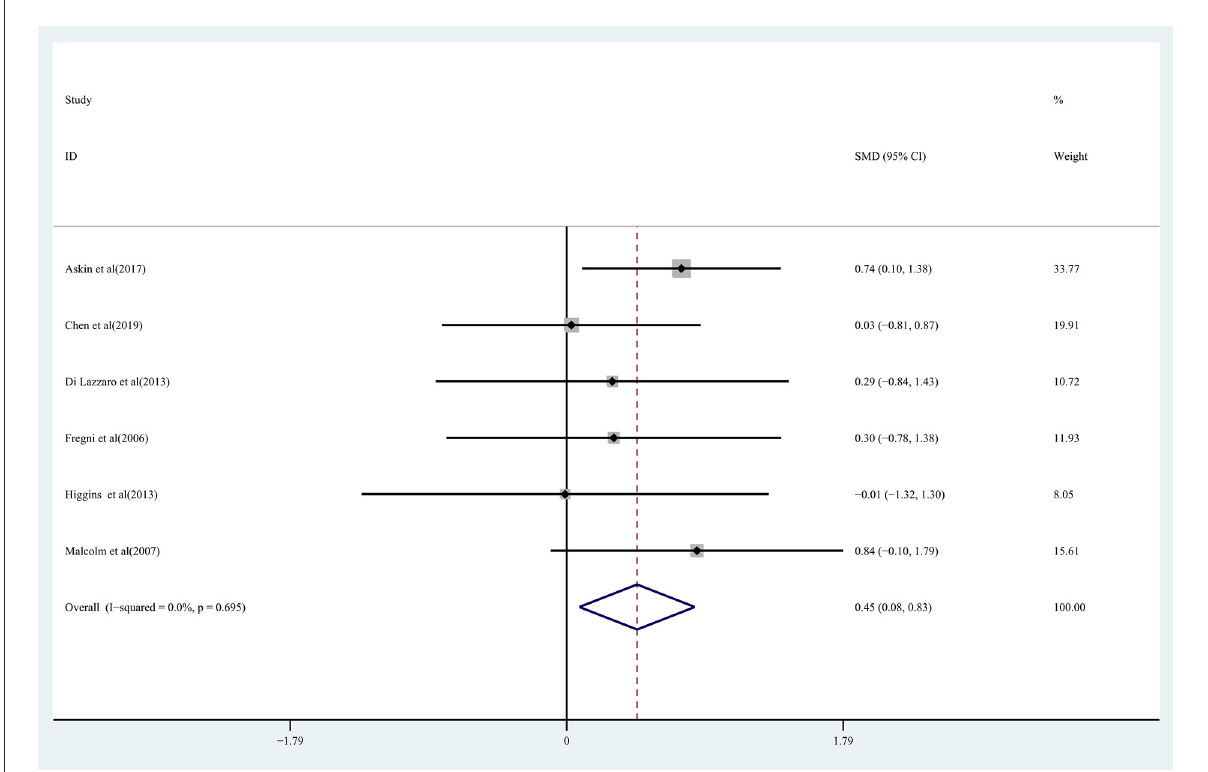
FIGURE3 Forest plot of the effect of rTMS treatment on hand function recovery in chronic stroke